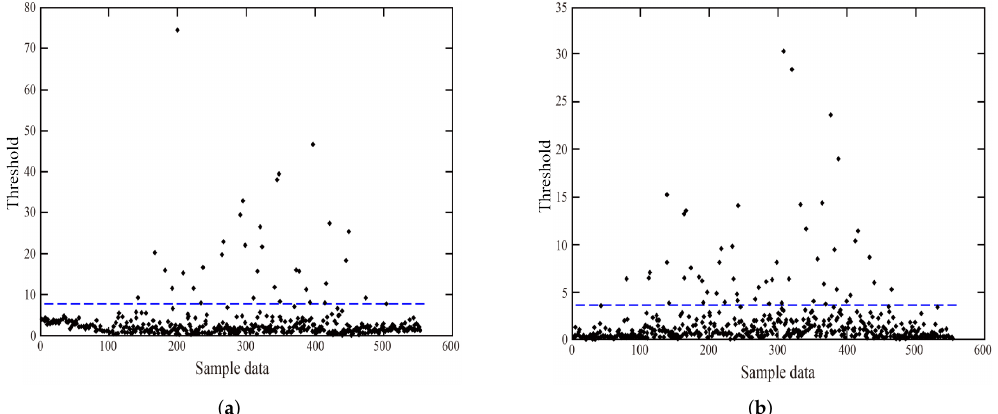
Figure 9. Control limit chart of MSPCA fault diagnosis model: ( a ) MSPCA- T 2 ; ( b )